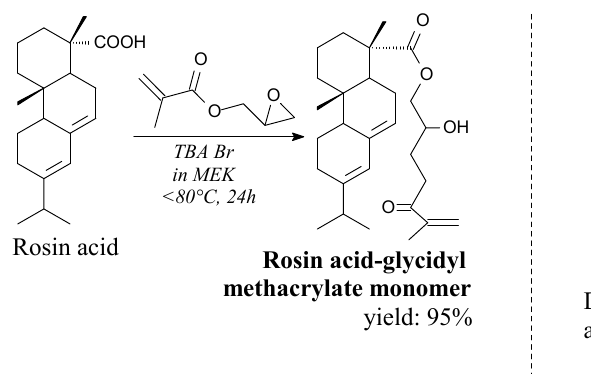
Scheme 15. Synthesis of rosin-based glycidyl methacrylate